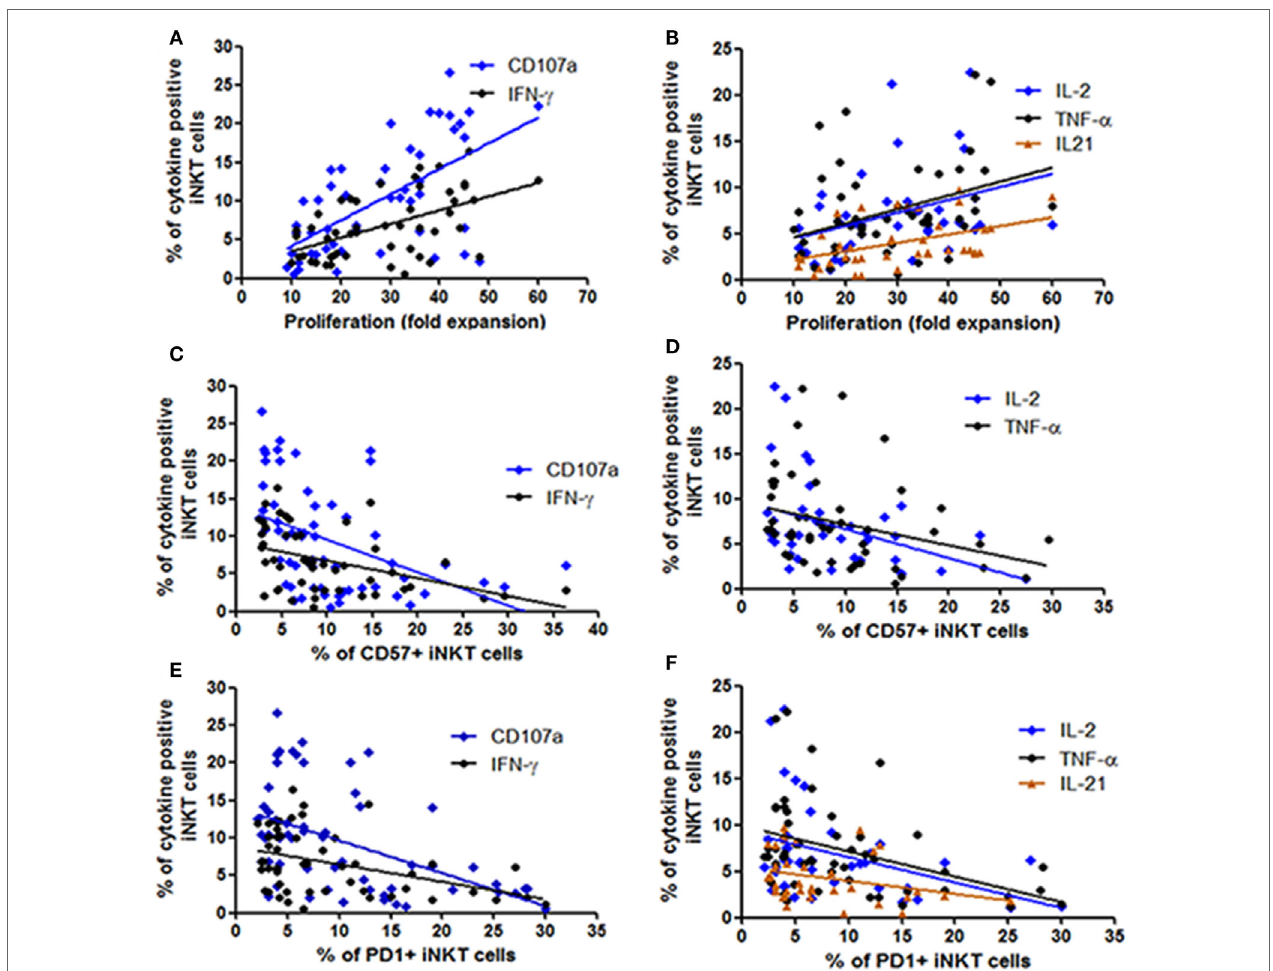
FigUre 4 | Assessment the relationship between functionality of invariant natural killer T (iNKT) cells with their proliferation ability and expression of immune exhaustion and senescence markers. The scatter diagrams represent the correlation between the percent of iNKT cells secreting cytokines and expressing CD107a on the Y -axis with (a,B) proliferation ability (fold expansion) of the corresponding iNKT cells on the X -axis, (c,D) corresponding CD57 expressing iNKT cells on the X -axis, and (e,F) corresponding PD1 expressing iNKT cells on the X